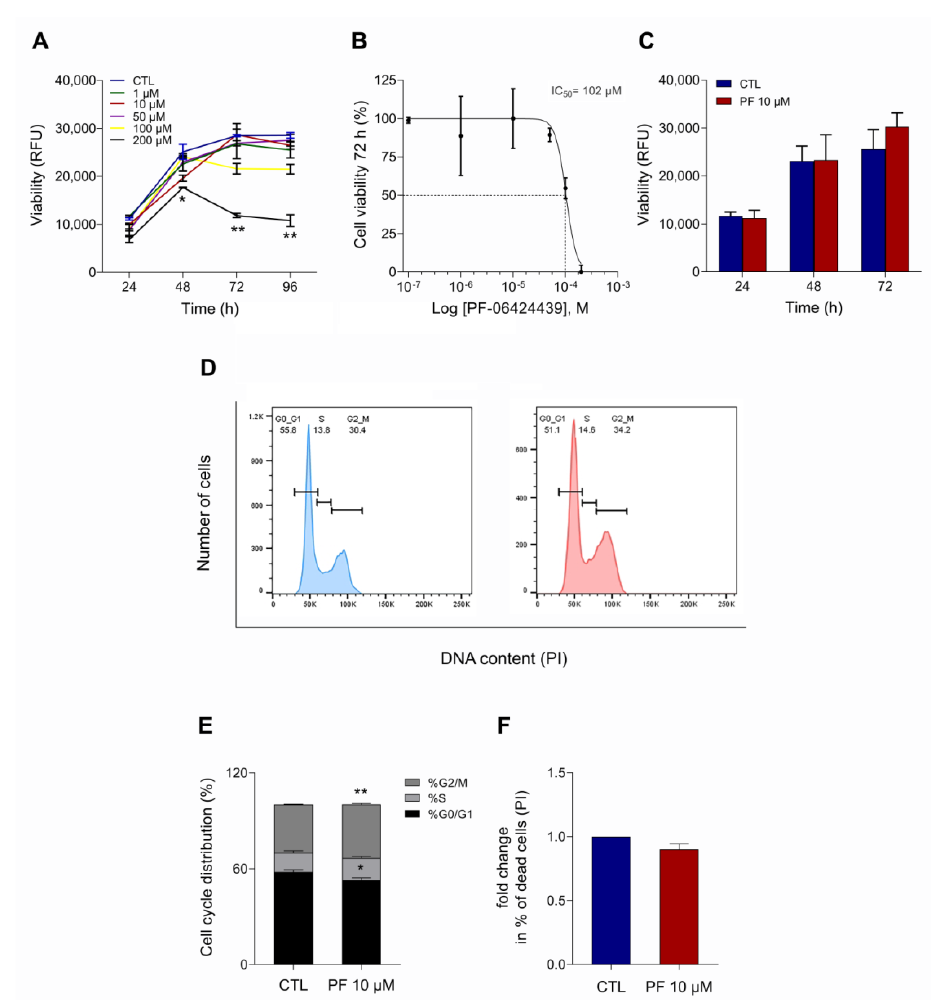
Figure 1. Effects of PF-06424439 on proliferation, cell cycle and cell death of MCF7 cells. ( A ) Cell viability of MCF7 cells treated with different concentrations (1, 10, 50, 100, and 200 µ M) of PF-06424439 compared with control (CTL) for 24, 48, 72, 96 h, as assessed by Presto blue assay and measured at 590 nm by using a spectrophotometer. RFU: Relative Fluorescence Units. ( B ) IC 50 was calculated in response to 72 h of exposure to different concentrations of PF-06424439. ( C ) Cell viability of MCF7 incubated with 10 µ M of PF-06424439 for 72 h. ( D ) Cell cycle distribution was analyzed in MCF7 cells treated with 10 µ M of PF-06424439 for 72 h compared with untreated cells. ( E ) Quantitative analysis of cells in G1, S and G2/M phases was determined by Flow Cytometry after PI staining as reported in the “Materials and Methods” section. ( F ) The fold change of dead MCF7 cells incubated with 10 µ M of PF-06424439 for 72 h was evaluated by Flow Cytometry using PI staining. All data are presented as mean ± SD of three independent experiments for each assay (* p ≤ 0.05, ** p ≤ 0.01).